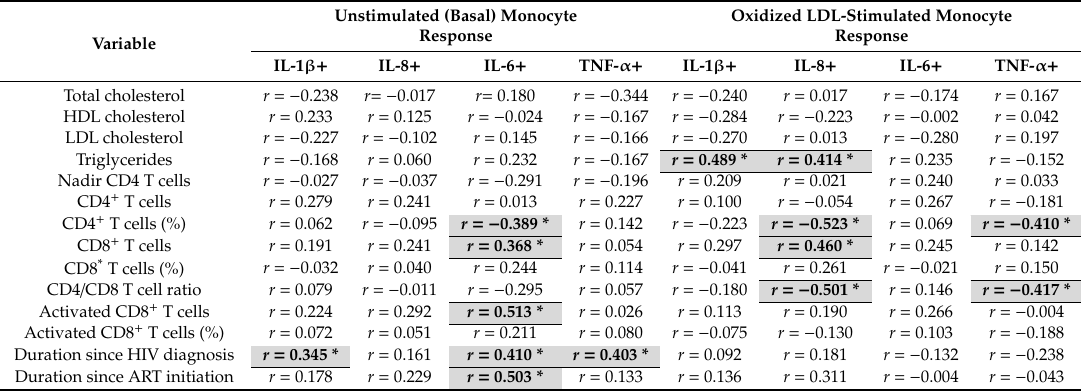
Table 2. Correlations between monocyte inflammatory responses and clinical parameters in people living with HIV / AIDS